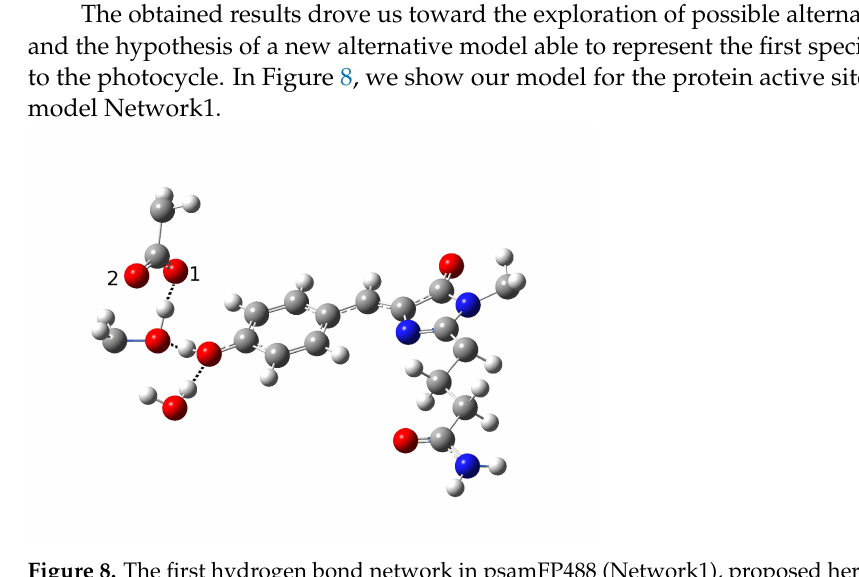
Figure 8. The first hydrogen bond network in psamFP488 (Network1), proposed here as the neutral form leading to